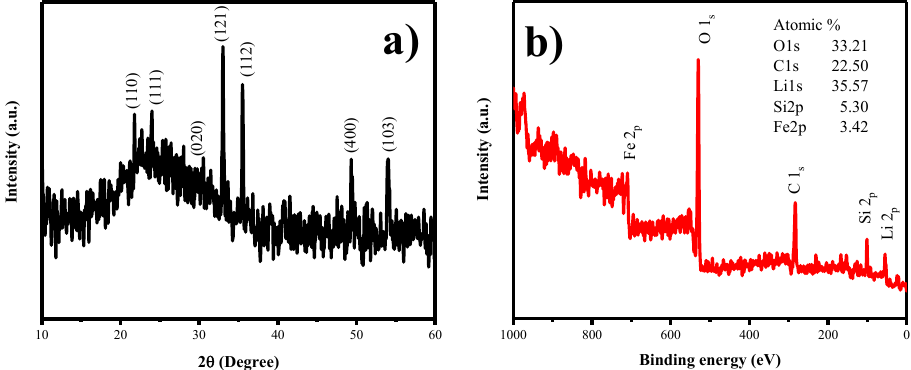
Figure 8. ( a ) XRD and ( b ) XPS spectrum of LFS@ESM after 100 cycles.